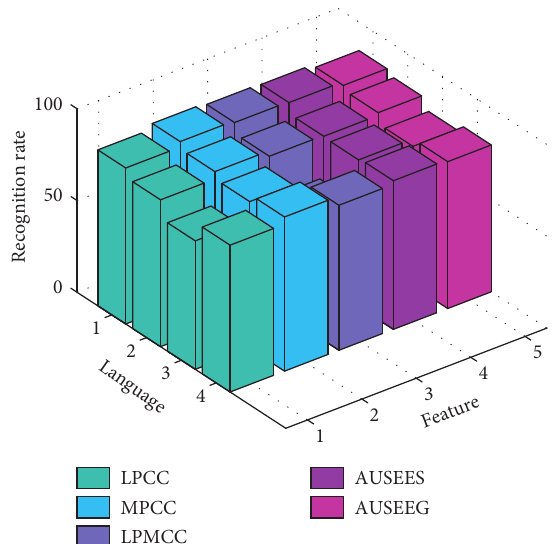
Figure 6: Comparison of recognition rates of different features in different languages.